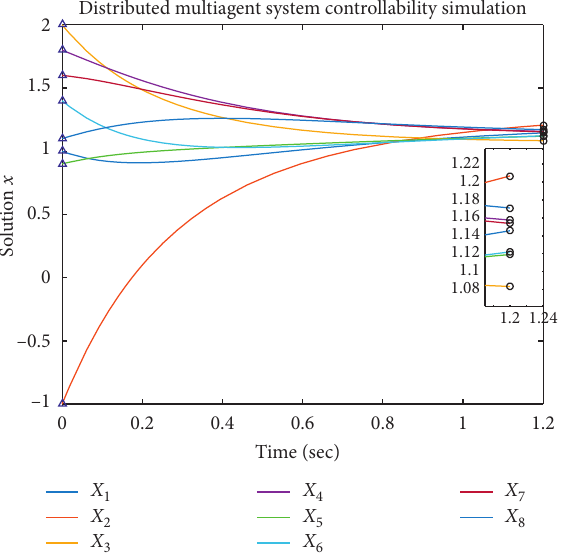
Figure 1: Controllability simulation of the